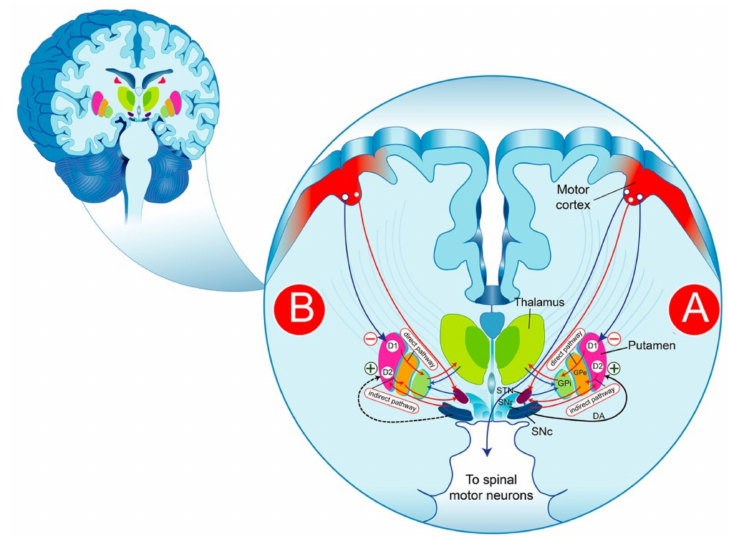
Figure 1. Schematic representation of DAergic pathways that regulate movement in the physiological condition ( A ) and PD ( B ). The substance P/dynorphin-positive MNS GABAergic neurons, expressing primarily D1R, send projections directly to the SNr and/or to the GPi. These neurons exert a tonic inhibition on the thalamic glutamatergic nucleus, which in turn sends excitatory projections to the motor cortex, thereby forming the direct pathway. The striatal enkephalin-positive MNS GABAergic neurons, expressing largely D2R, send projections to the GPe, which in turn project their axons to the glutamatergic neurons of the subthalamic nucleus and inhibit the neurons in this structure. In the subthalamic nucleus, the neurons are excitatory glutamatergic neurons that send projections to the globus pallidus (internal segment) resulting in the disinhibition of the subthalamic nucleus neurons, which, in turn, activate neurons in the internal segment of the globus pallidus to inhibit the thalamus, reflected by the inhibition of movements. DA-dopamine; GPi-globus pallidus internus; SNr-substantia nigra reticulata; SNc-nigra pars compacta; STN-subthalamic nucleus;